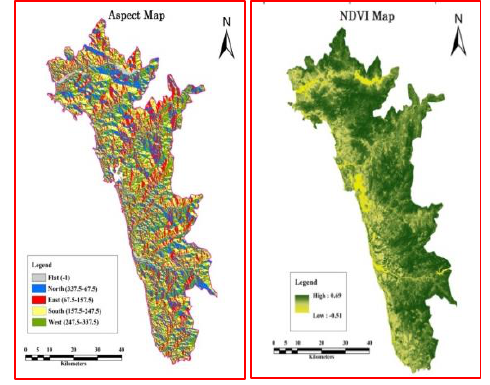
Figure 3. Aspect and NDVI map of coastal region of UK district